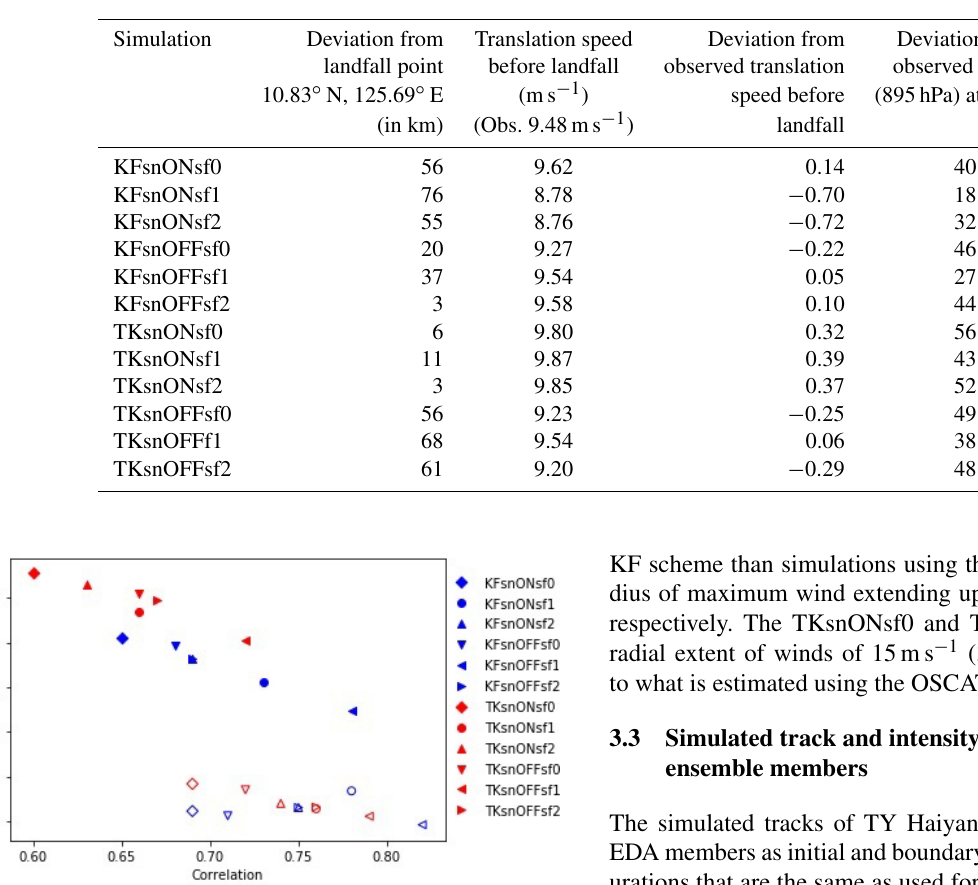
Table 4. The resulting deviation from landfall location (km, rounded to nearest whole number), translation speed (ms − 1 , rounded to two decimal place), and deviation from observed translation speed (ms − 1 , rounded to two decimal places), as well as deviation of the simulated MSLP at landfall (hPa, rounded to the nearest whole number), compared to observations.